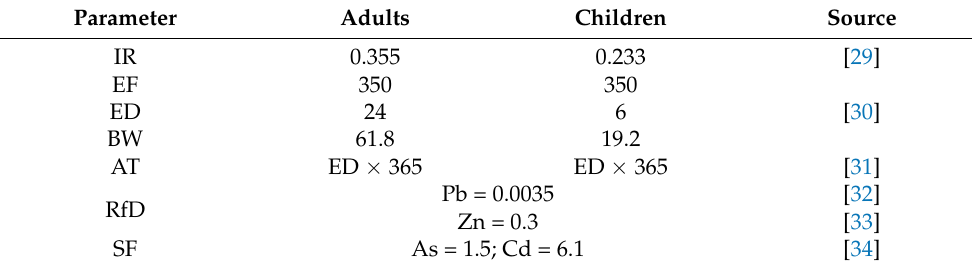
Table 3. Parameters in the human health risk assessment model.